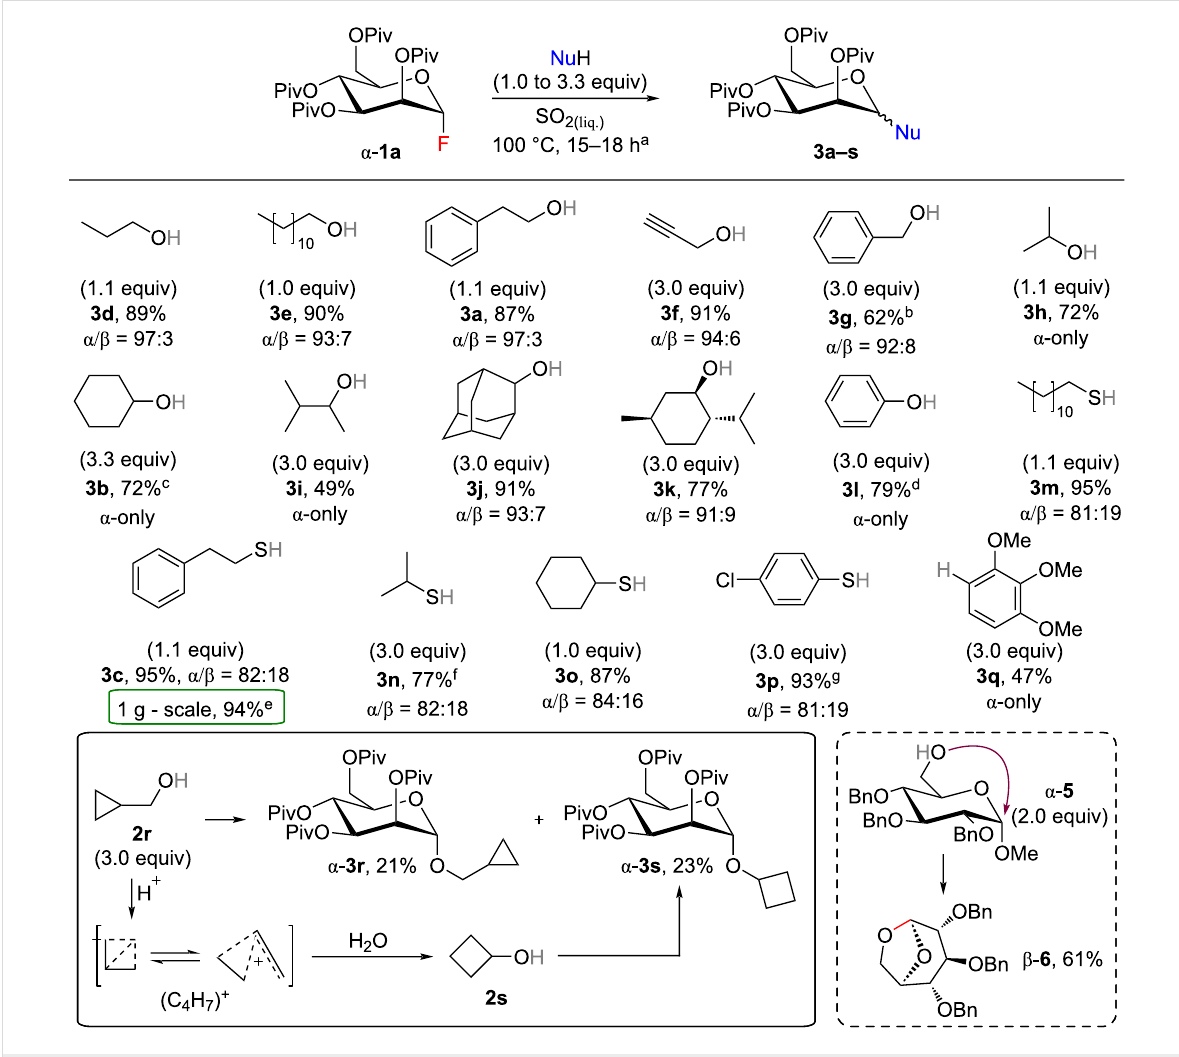
Scheme 1: Scope of glycosyl acceptors for glycosylation with pivaloyl-protected mannosyl fluoride α - 1a in liquid SO 2 . a Unless otherwise stated, reac- tions were carried out by using 0.193–0.771 mmol of α - 1a and 25 ± 5 g of liquid SO 2 ; α / β ratios were determined by 1 H NMR analysis of the crude